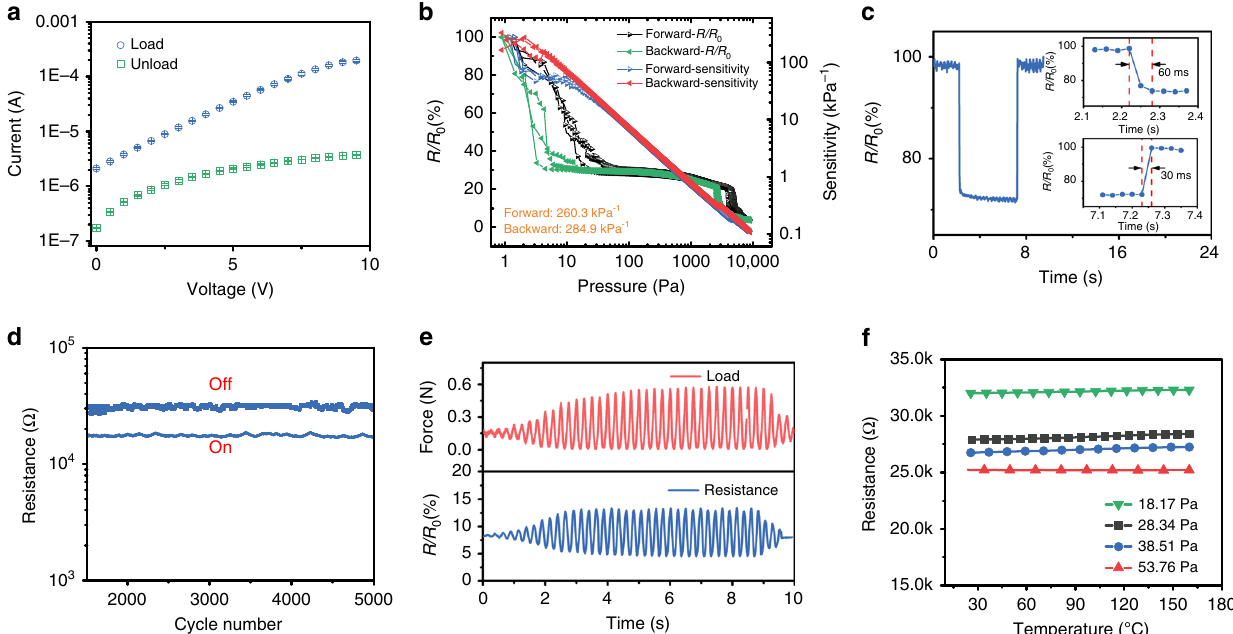
Fig. 2 Elastic and resistance behavior of the thin- fi lm sensor. a Current – voltage characteristic of an unloaded and loaded (80 Pa) sample of the urchin- like hollow carbon sphere polydimethylsiloxane fi lm (UHCS-PDMS), respectively. The error bars represent one standard deviation. b Resistance response and pressure sensitivity of the pressure sensor after normalization. c Instant response of the pressure sensor, which exhibits a response time of 60 ms for loading and 30 ms for unloading. The inserts are the magni fi ed curves. d Resistance of the sensor at a pressure between 20 and 200 Pa in the 5000 cycles fatigue test. e Resistance changes under a tuned loading force of different amplitudes at 4 Hz with two 6.25 cm 2 ITO electrodes. f Response of the sensor to different applied pressures from 25 to 160 °C.